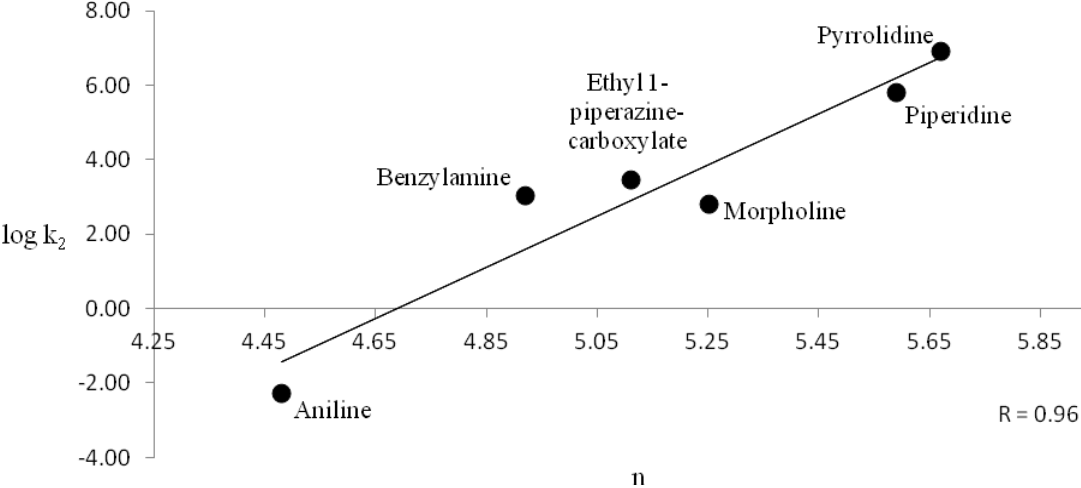
for methyl chloroformate—amine 2